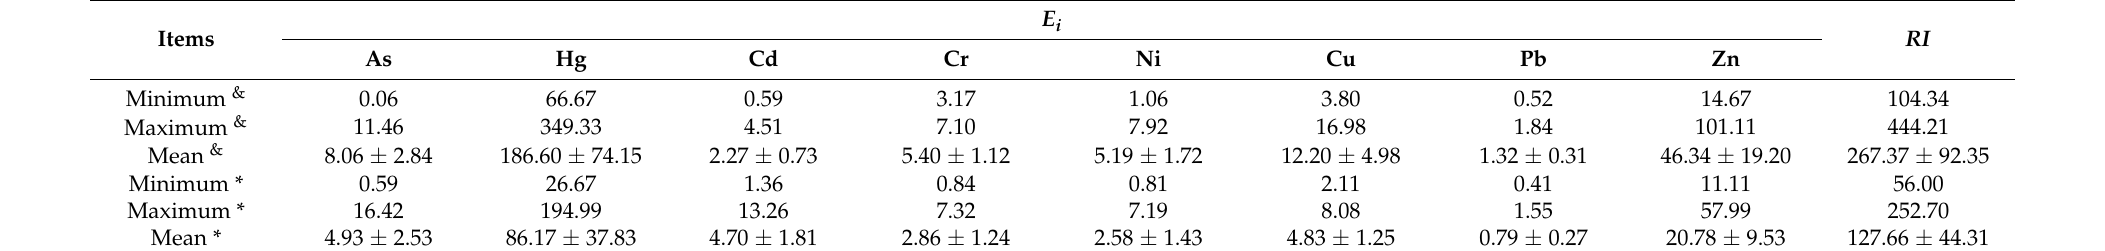
Table 4. Calculation results of the E i and RI in the surface sediments and sediment core of Yueliang Lake.